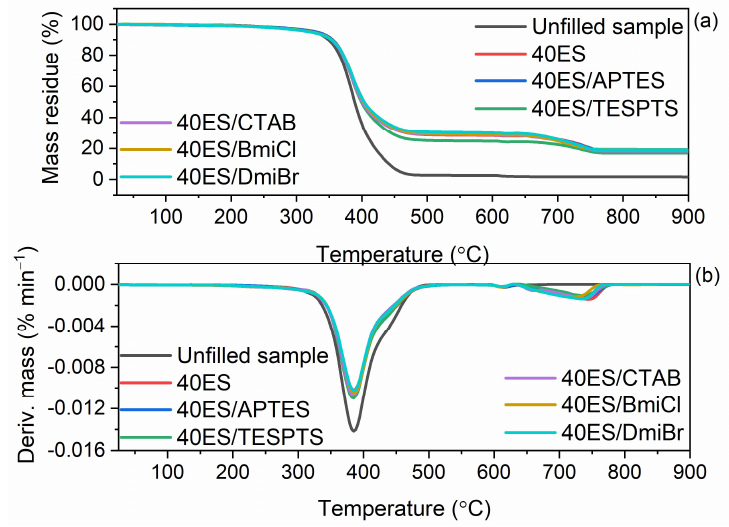
Figure 12. TG and DTG curves of NR vulcanizates filled with 40 phr of ground eggshells containing silanes, ILs, and CTAB: ( a ) TG curves; ( b ) DTG curves.